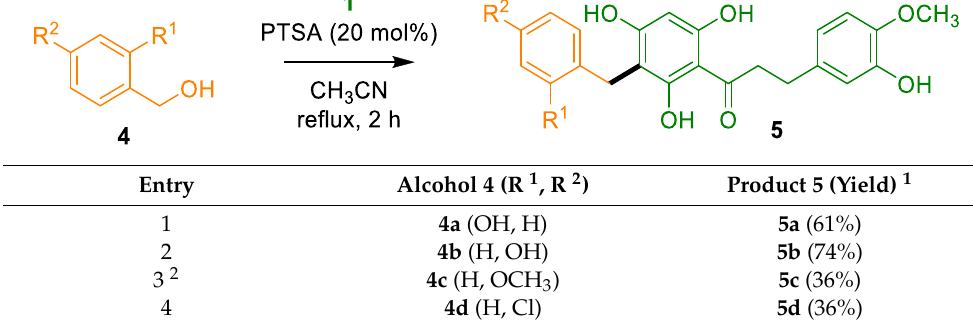
Table 3. Catalytic Prenylation of Dihydrochalcone 1